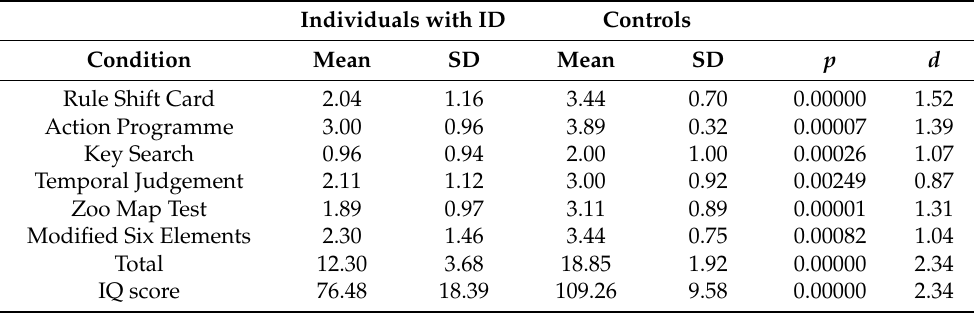
Table 1. Mean performance (and SD) in the Behavioral Assessment of Dysexecutive Syndrome (BADS) tests of individuals with intellectual disability (ID) and controls. The p -values associated with Student’s t -tests are presented; based on the Bonferroni correction for multiple comparisons, p < 0.007 are considered significant. Effect sizes (Cohen’s d values) are also reported. Individuals with ID Controls Condition Mean